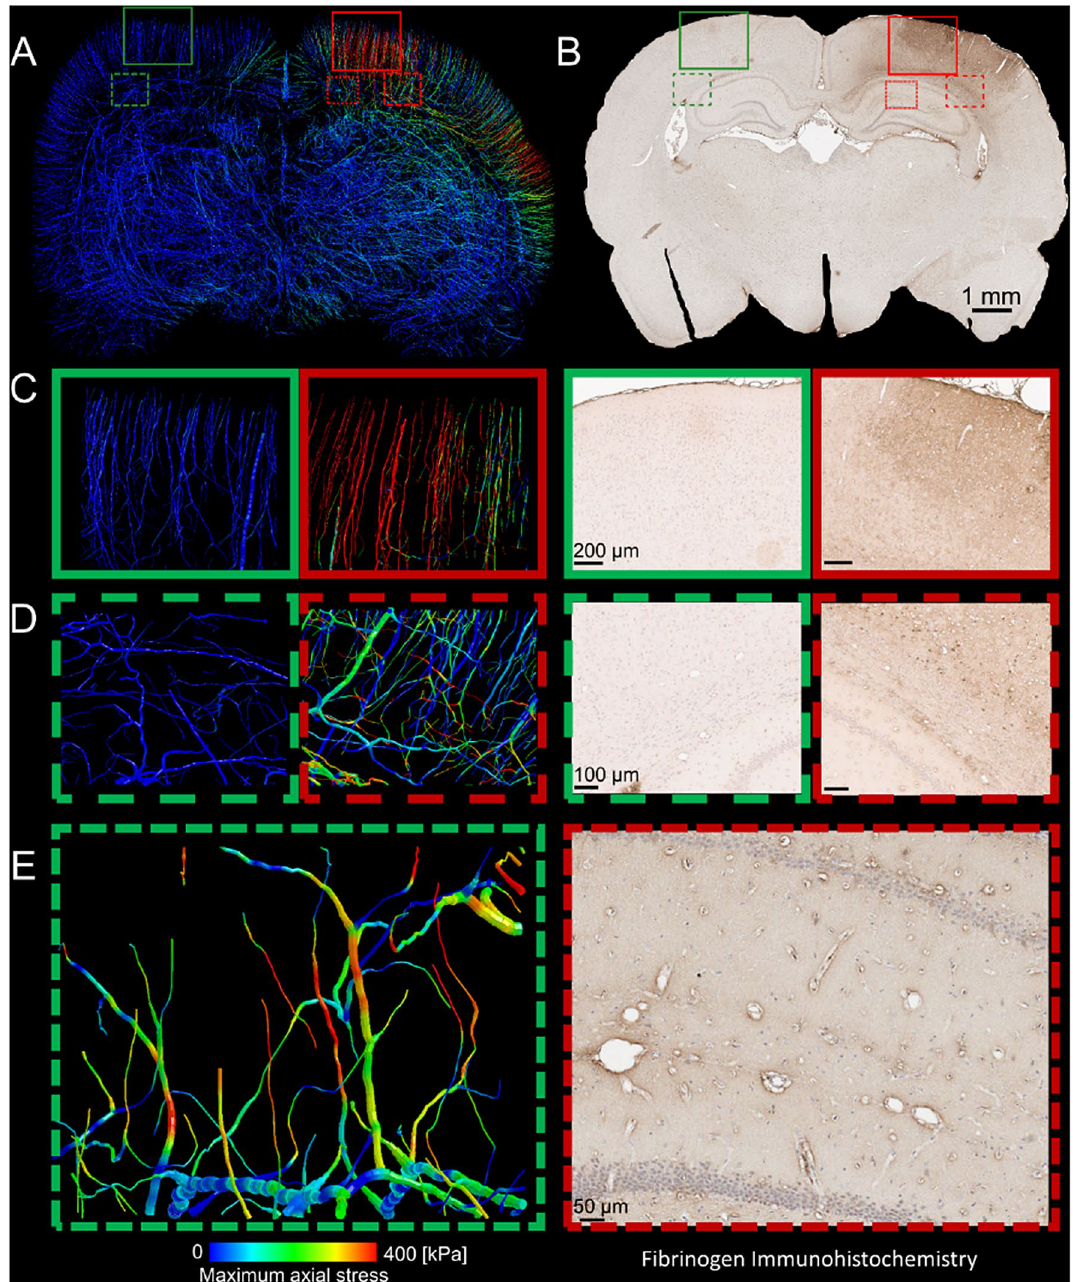
Figure 1. Computational modelling predicts Fibrinogen extravasation. ( A ) The axial stress distribution within the vasculature, ( B ) representative whole brain photomicrograph of sections from animals subjected to 2 mm CCI (3 days post injury) at − 3.12 mm from bregma stained for Fibrinogen. Computational prediction of maximum axial stress and corresponding Fibrinogen staining in ( C ), the contra- (green) and ipsilateral (red) cortex, the contra- (green) and ipsilateral (red) Corpus Callosum, ( D,E ) at the microstructural level of the